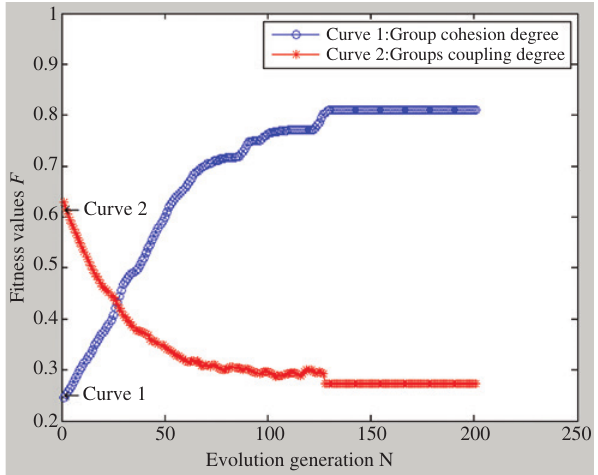
Figure 9: The Optimization Function